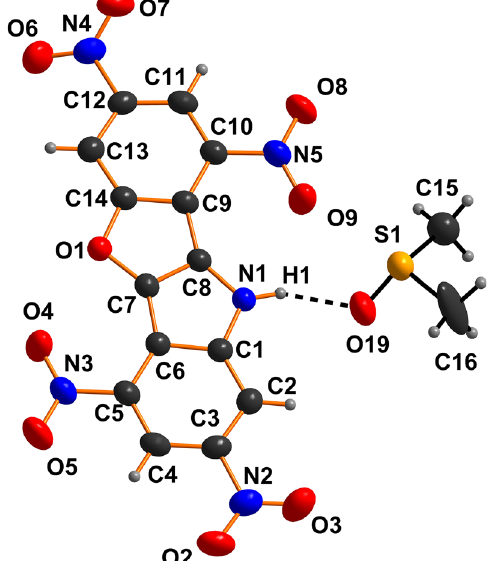
Table 1 contains crystallographic data and Table 2 contains the list of the atoms including atomic coordinates and displacement